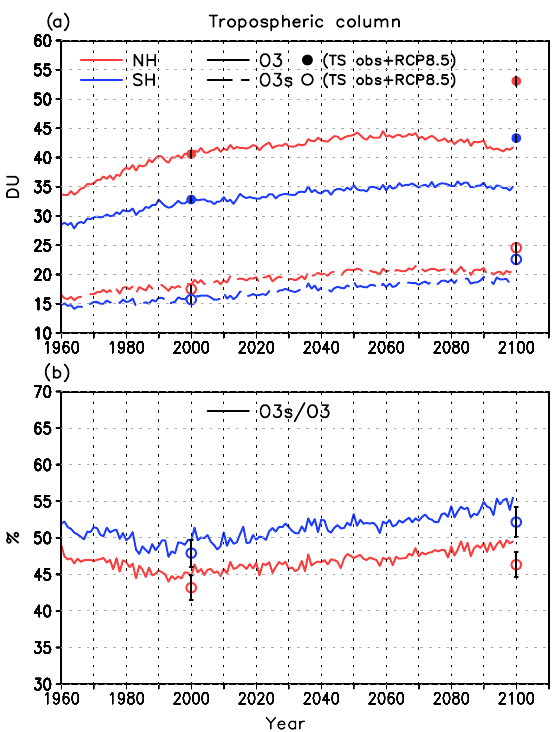
Figure 10. (a) Temporal evolution of the annual mean tropospheric column in ozone (solid) and O 3 s (dashed) [DU] averaged for the Northern Hemisphere (red) and the Southern Hemisphere (blue) in the transient RCP6.0 simulation and the corresponding values of the reference time-slice simulations for the year 2000 and 2100 (ozone: closed circle; O 3 s: open circle). (b) Same as (a) but for the ratio between O 3 s and O 3 [%]. The black bars denote the ± 2 σ range for the time-slice simulations. Note that the interannual variability in ozone and O 3 s is small in the time-slice simulations and the error bars are very